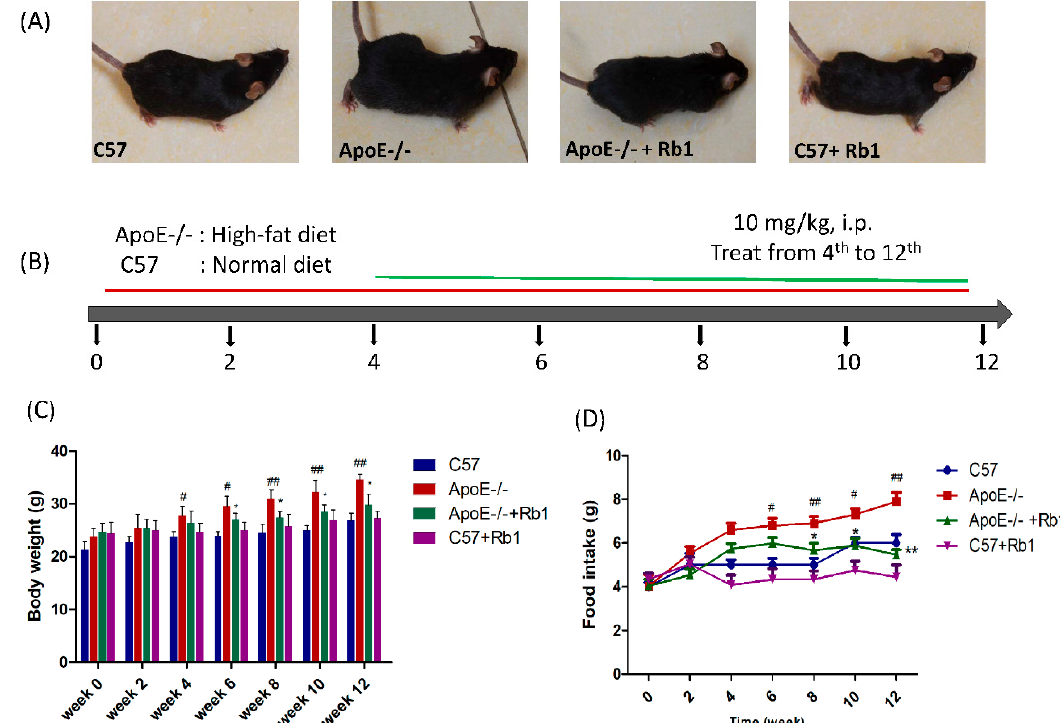
Figure 2. Rb1 suppressed body weight and food intake in ApoE-/- mice fed a high-fat diet. ( A ) Status of C57 and ApoE-/- mice in each group after Rb1 or vehicle administration. ( B ) C57 mice fed a normal diet and ApoE-/- mice fed a high-fat diet. ApoE-/- mice and C57 mice were treated intraperitoneally with Rb1 (10 mg/kg i.p.) or the same volume of vehicle in saline from the 4th week to the 12th week. ( C ) Body weight of the mice in all groups during 12 weeks of a high-fat diet. ( D ) Food intake of mice in all groups during 12 weeks of treatment with a high-fat diet. The data are expressed as the mean ± the standard error (SE) of the mean in each group ( n = 10). ## p < 0.01, # p < 0.05 vs. C57 control; * p < 0.05, ** p < 0.01 vs. ApoE-/- model.